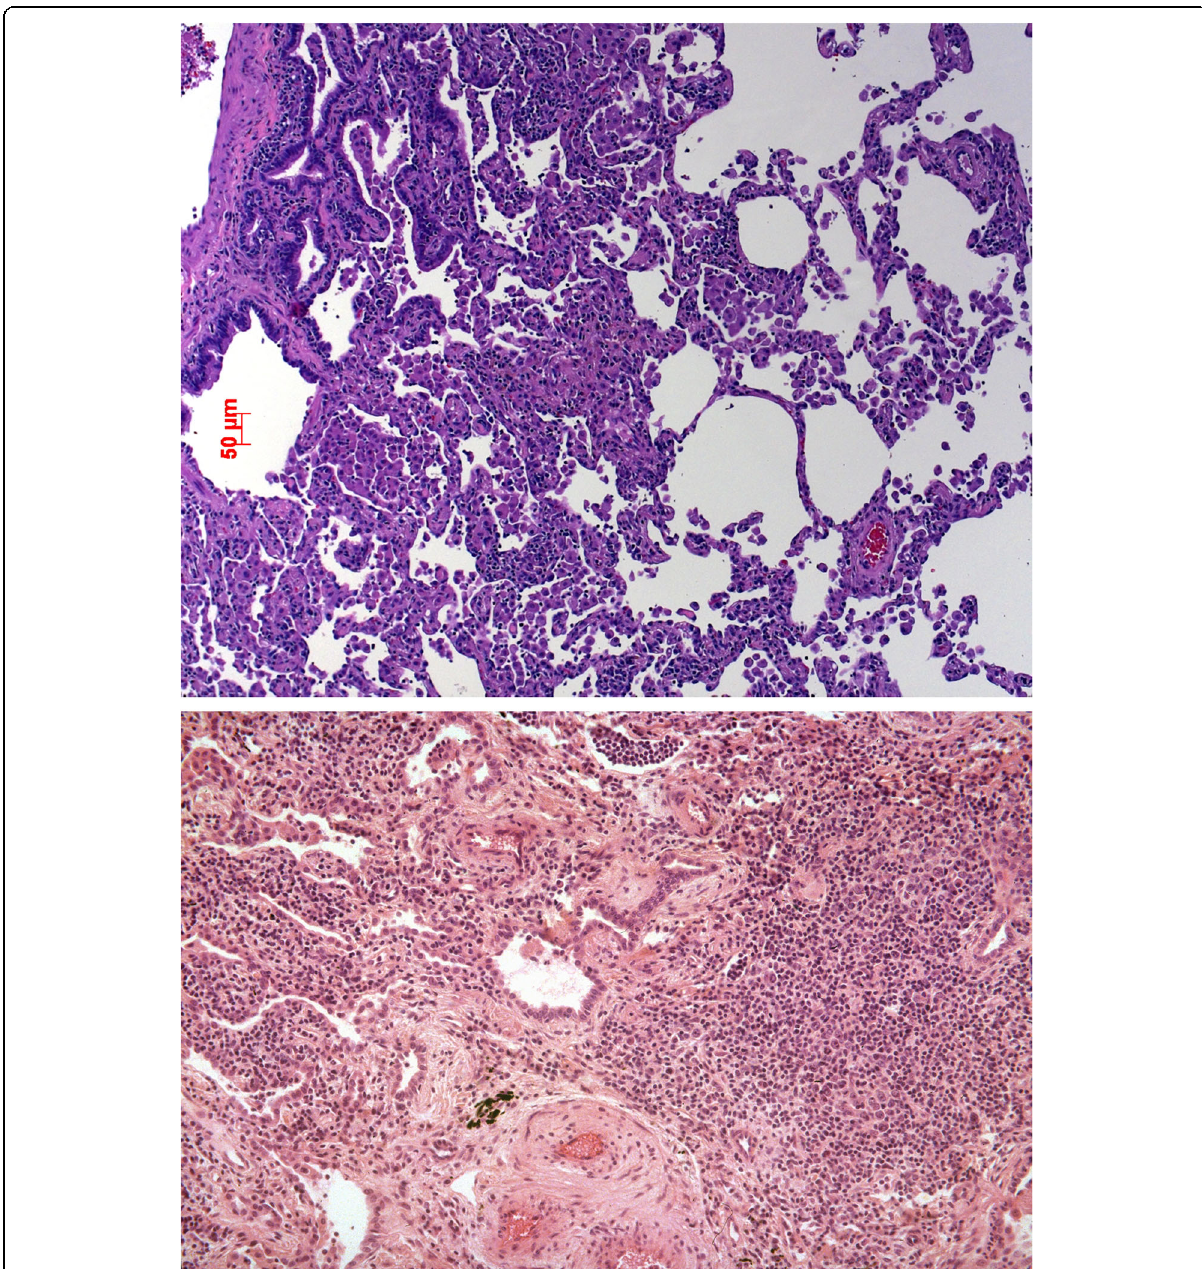
Fig. 21 NSIP upper versus LIP lower panel; whereas the infiltrating cells in cellular NSIP are mixed, the lymphocytic infiltration in LIP is monomorphic. H&E, bars 50 μ